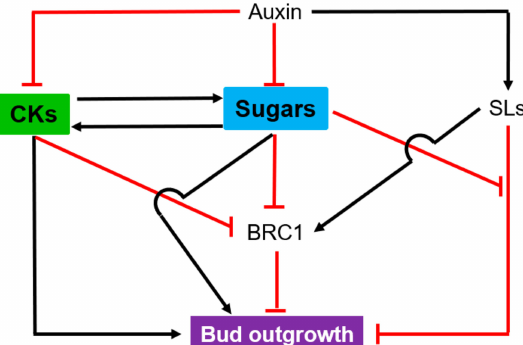
Figure 5. Synergistic effect of sugars and cytokinins (CKs) on bud outgrowth. Black arrows and red lines indicate stimulatory and inhibitory effects, respectively. SLs: strigolactones; BRC1: Branched1. Current evidence shows crosstalk between sugars and SLs in rose, pea and rice